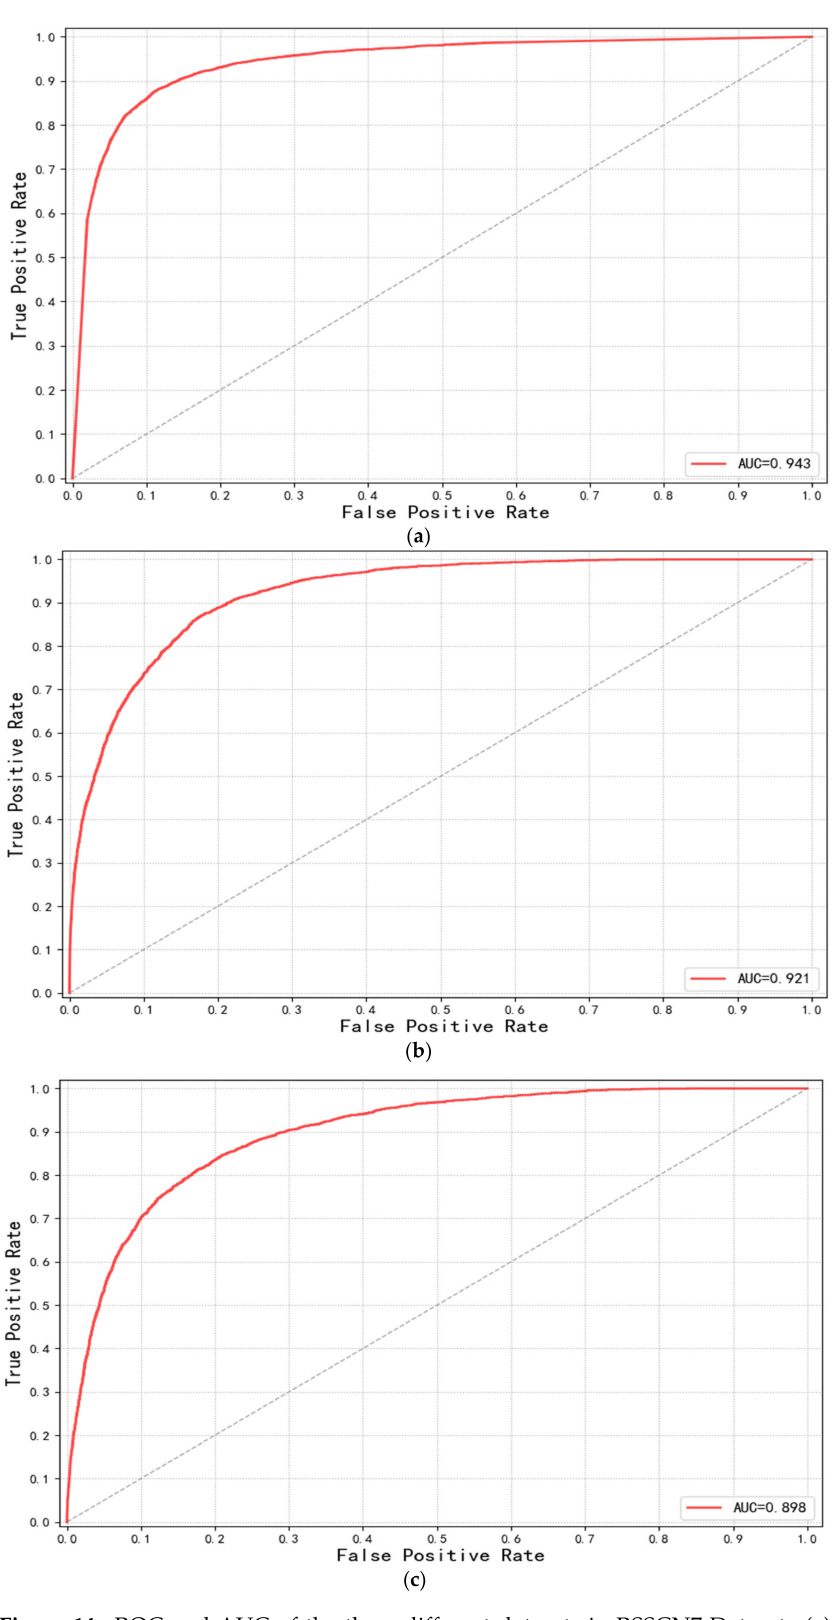
Figure 14. ROC and AUC of the three different datasets in RSSCN7 Dataset. ( a ) Datasets with fake samples generated by the improved SinGAN, ( b ) Datasets with true samples used for the training of the improved SinGAN, ( c ) Datasets with random samples selected randomly by the classifier